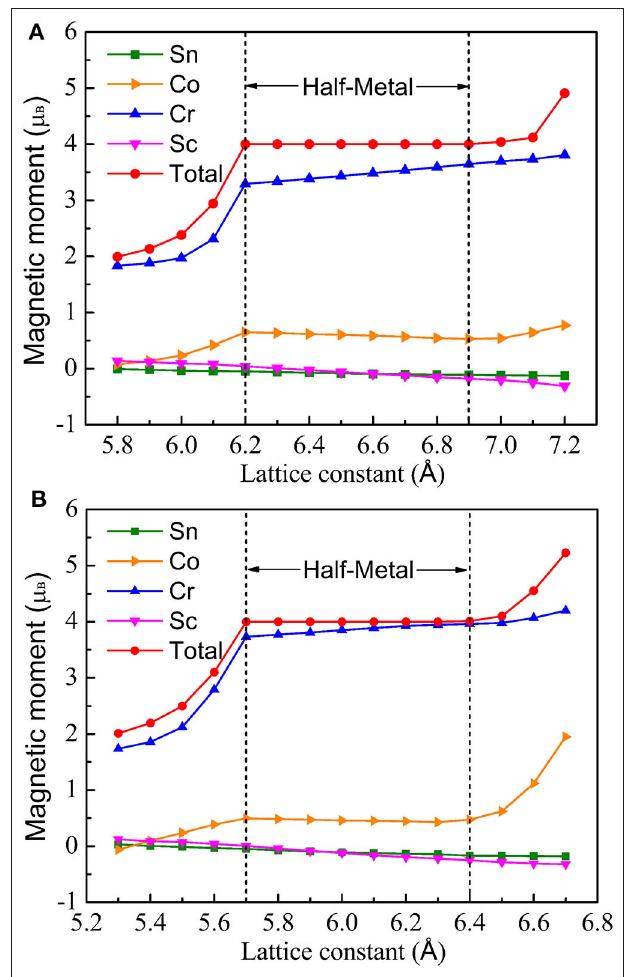
FIGURE 7 | Total and atomic magnetic moments of CoCrScSn compound at different lattice constant. (A) GGA, (B) GGA +